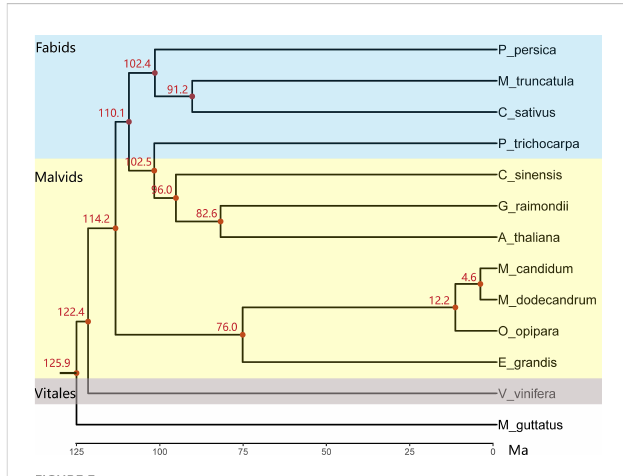
FIGURE 3 The chronogram tree of 12 rosids species and one outgroup based on the concatenated sequences of 346 single-copy genes. All nodes have a 100% bootstrap support value. The three different background colors (top to bottom) represent Fabids, Malvids and Vitales based on APG IV (2016), respectively. Species abbreviations: A_thaliana, Arabidopsis thaliana ; C_sinensis, Cirtus sinensis ; C_sativus, Cucumis sativus ; E_grandis, Eucalyptus grandis ; G_raimondii, Gossypium raimondii ;